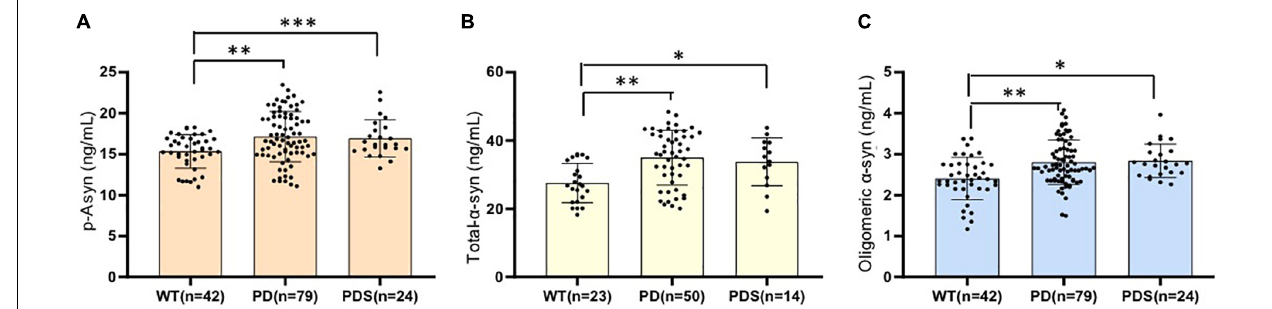
FIGURE 2 | Lewy body-associated proteins are elevated in the plasma of patients with PD. Plasma p-Asyn at ser129 (A) , total α -syn (B) , and oligomeric α -syn (C) levels for healthy controls, patients with PD, and PDs included in this cross-sectional analysis. Mean plasma Lewy body-associated proteins levels were significantly increased in patients with PD and PDs compared to age-matched healthy controls ( p < 0.05, Mann–Whitney U test). * P < 0.05, ** P < 0.01, and *** P <